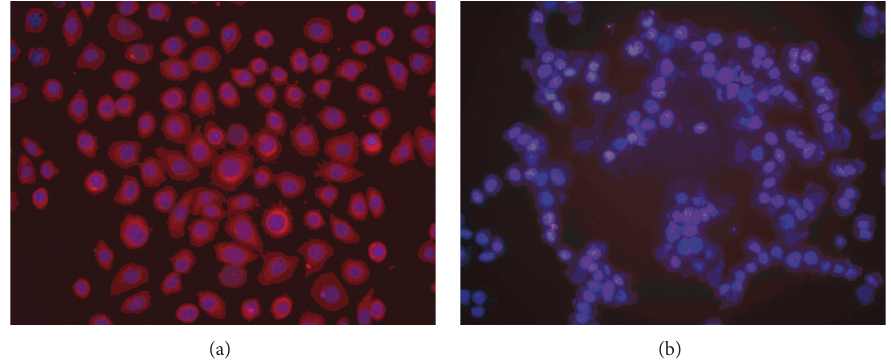
Figure 5: Immunofluorescence of the cellular location analysis of expression products of gene HSP74 showed that they are all distributed in cellular membrane, cytoplasm and nucleus (a), negative control (b) × 200.